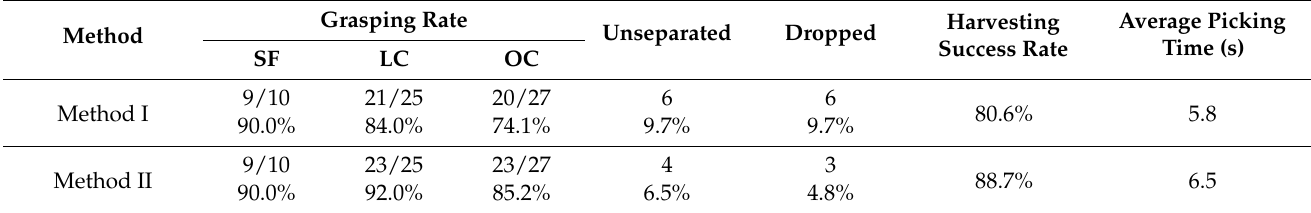
Table 2. The results of robotic picking test in kiwifruit orchard.